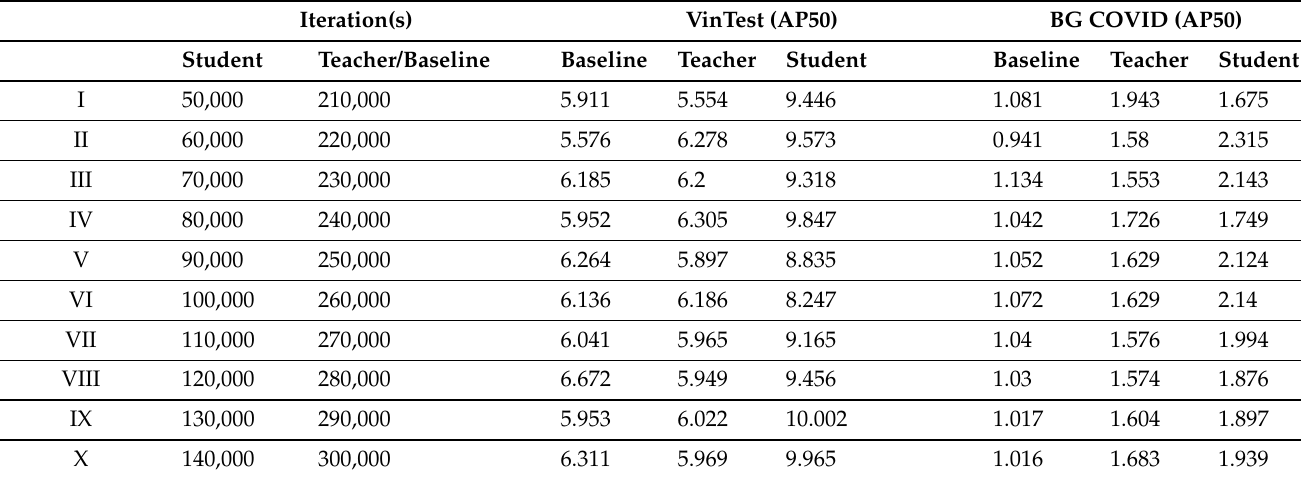
Table 7. Performance evaluation on VinTest and BG COVID